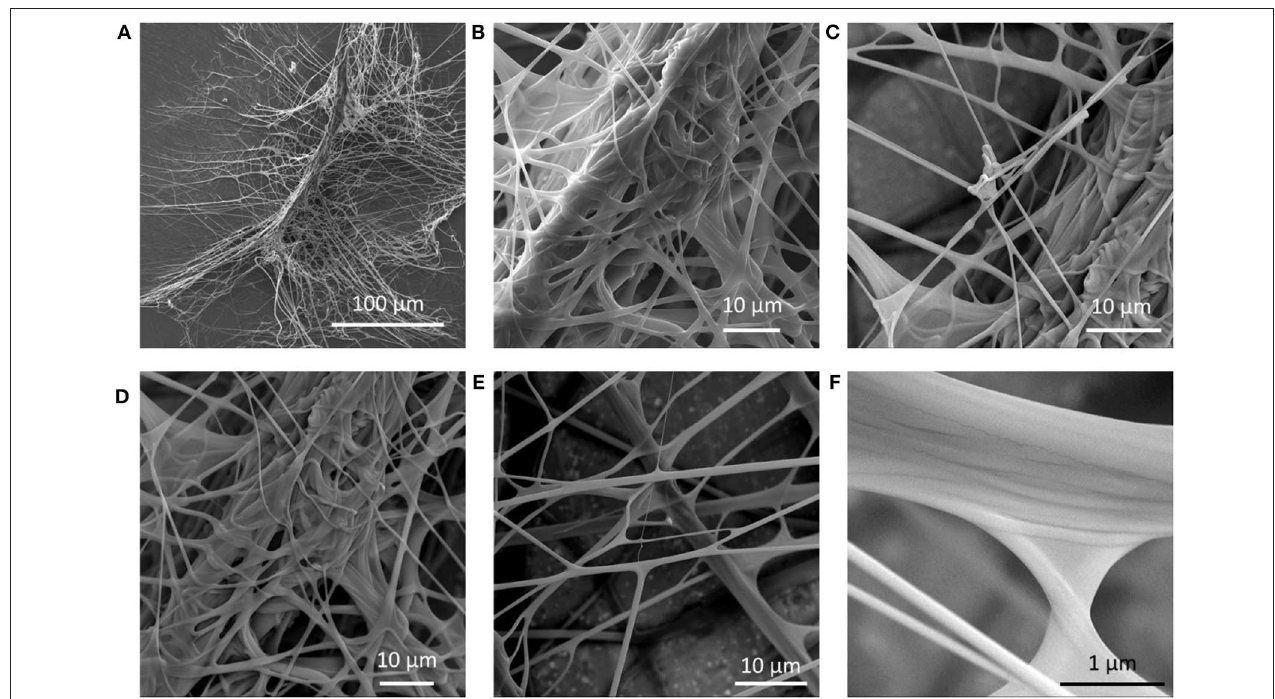
FIGURE 2 | Scanning electron microscopy (SEM) images of an attachment disc of Cupiennius salei. (A) The structure is composed of a dragline thread that is suspended in a network of glue-coated fibrils. (B–F) Different details of the piriform silk network in the attachment disc.